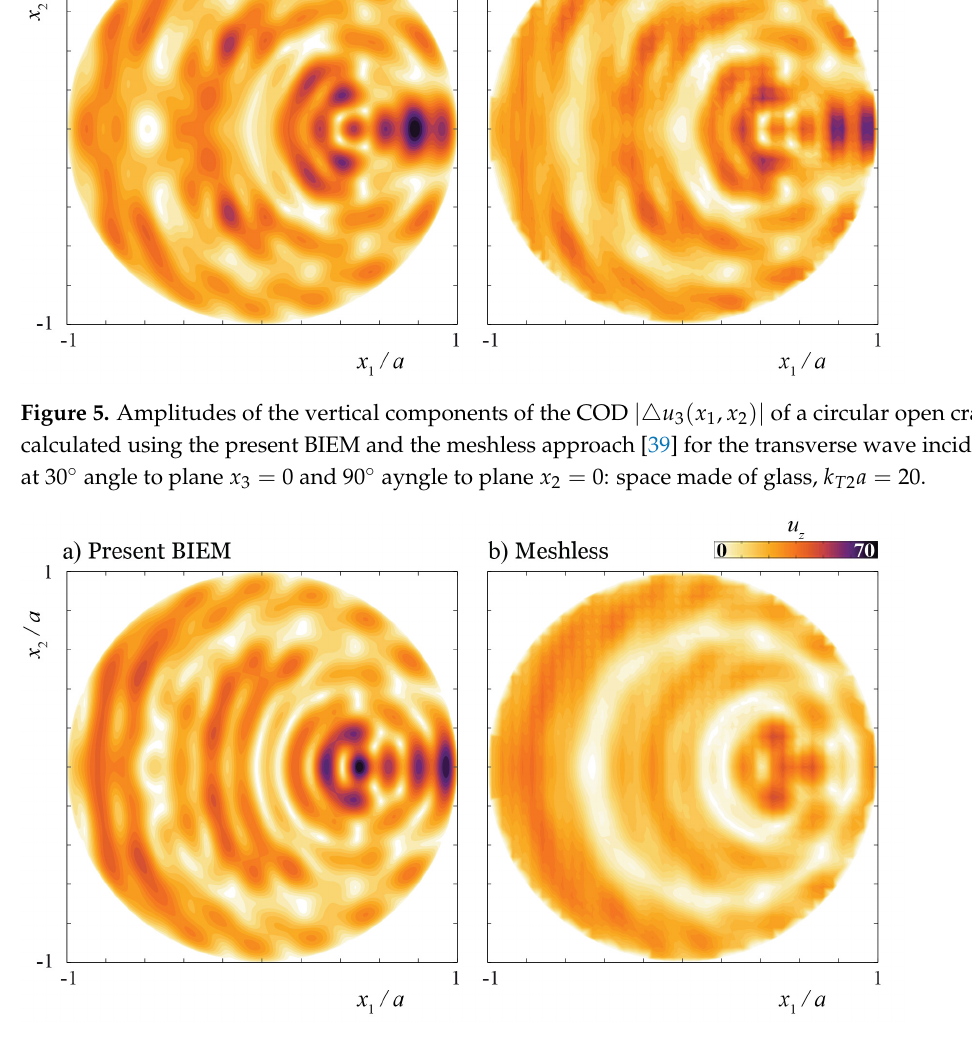
Figure 6. Amplitudes of the vertical components of the COD |(cid:52) u 3 ( x 1 , x 2 ) | of a circular open crack calculated using the present BIEM and the meshless approach [39] for the transverse wave incident at 30 ◦ angle to plane x 3 = 0 and 90 ◦ angle to plane x 2 = 0: two half-spaces made of aluminium and polycarbonate, k T 2 a =